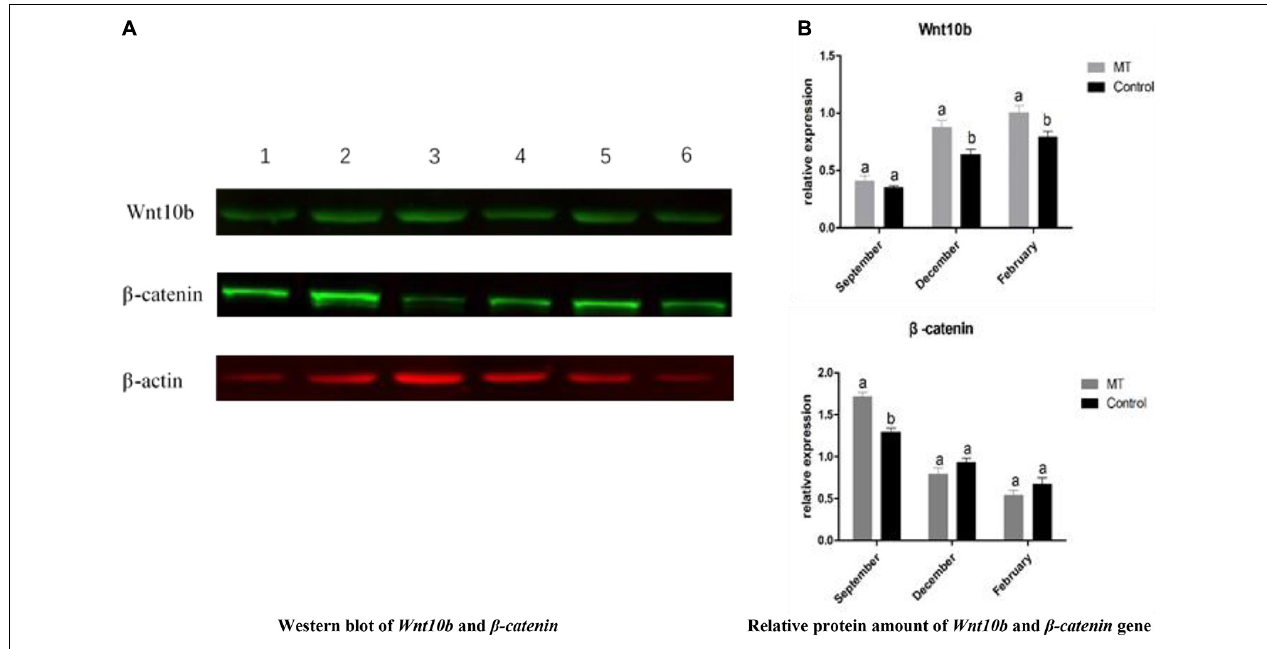
FIGURE 8 | (A) Western blot and quantitative analysis of Wnt10b and β -catenin genes. The one, two, and three bands were Wnt10B, β -catenin , and β -actin of the test group in February, October, and December, respectively; the four, five, and six bands were Wnt10B, β -catenin , and β -actin of the control group at February, October, and December, respectively. (B) The same letter represents no significant difference, while different letters represent significant